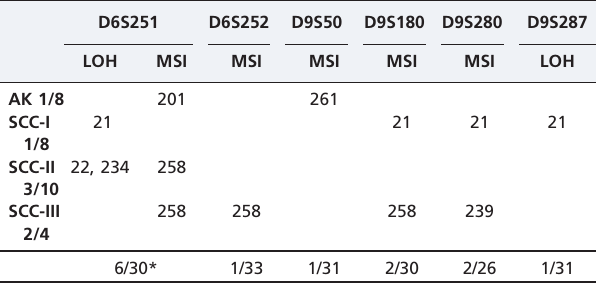
Table 2 - The patients who carried MSI or LOH mutations were indicated for each microsatellite, according to their laboratory list number. The bottom row indicates the total number of alterations found in all of the patients with informative results. (*) The total alterations of D6S251 were significantly greater in the SCC (I + II + III) compared with the AK lesions ( p = 0.0398).